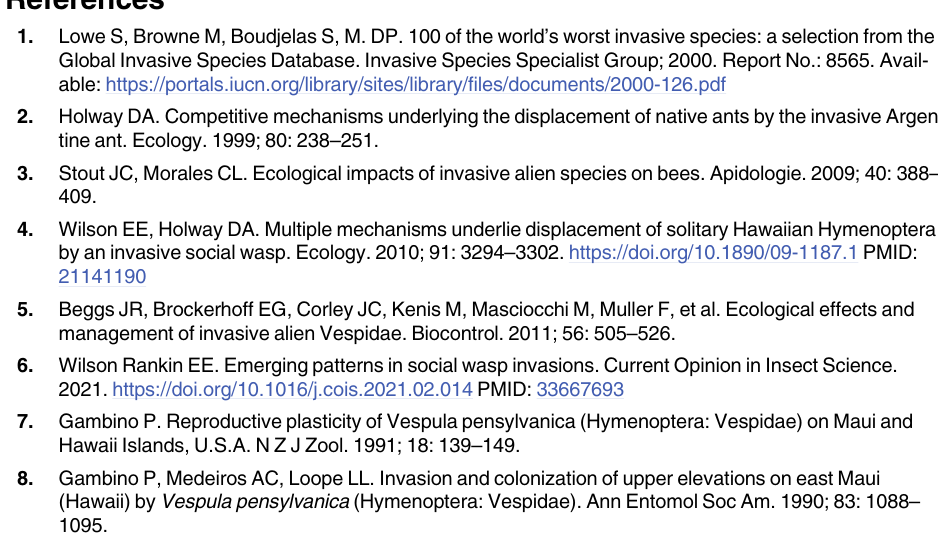
S1 Table. Latitude and longitude coordinates and sampling dates for each sample. “R” denotes “Riverside” and “H” denotes Hawaii sampling